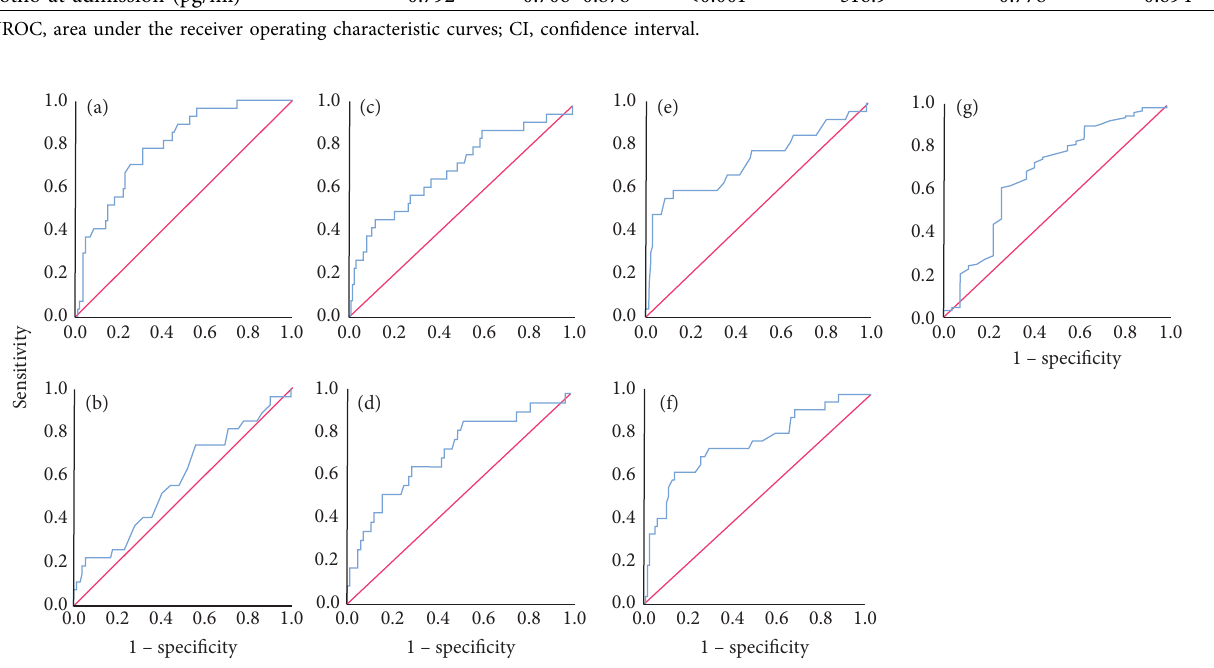
Figure 1: Comparison of discrimination performance of Klotho, SCr, eGFR, BNP at admission and systolic pressure, LVEF, and he- moglobin regarding the incidence of AKI after AMI. Te respective AUROC are 0.792 ( p < 0 . 001), 0.583 ( p � 0 . 179), 0.698 ( p � 0 . 001), 0.717 ( p � 0 . 001), 0.726 ( p < 0 . 001), 0.765 ( p < 0 . 001), and 0.680 ( p � 0 . 003) according to (a)–(g). (a) α -Klotho at admission. (b) SCr